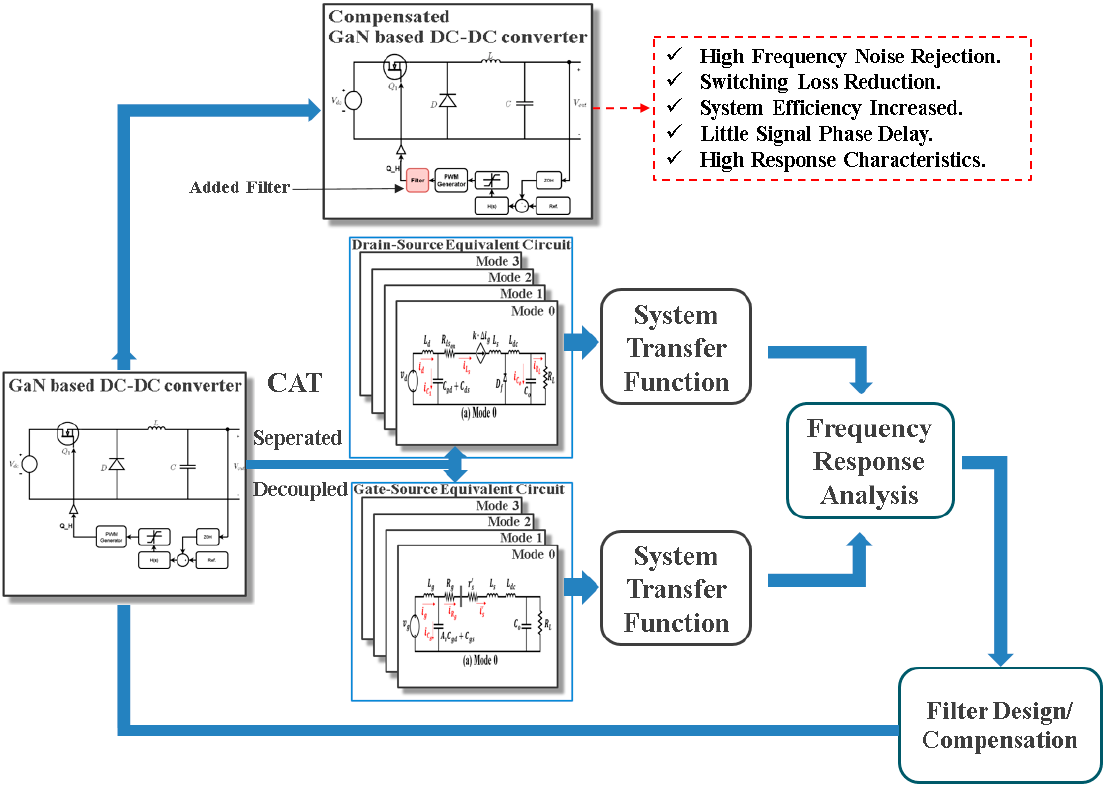
Figure 2. The proposed WBG device system design and compensation flow in this paper.